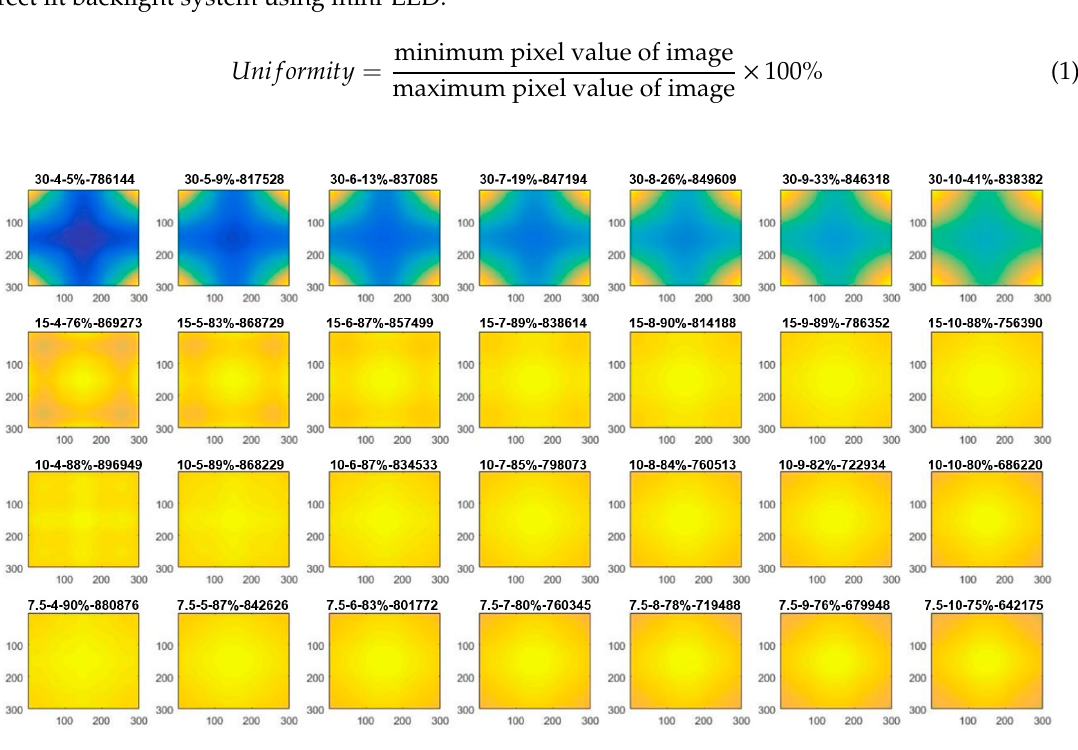
Figure 6. Array analysis of SMD. Figure 5 is an image series of an array of CSPs. Qualitatively, when Pitch = 30 mm, since the illumination type of the light source is the Gaussian distribution, the light pattern cannot be effectively opened in the interval of OD = 4 mm to 10 mm. Therefore, the images all show obvious cross-dark characteristics (blue area). As shown in Figure 6, SMD also has the same characteristics, while FDCSP has no obvious cross-dark band when OD = 8 mm or more, such as Figure7. Based on the above results, the bat wing light type clearly has the ability to provide large Pitch solution on the display plane. On the other hand, as can be seen from Figure 5, Figure 6 and Figure 7, the image uniformity increases significantly as the Pitch shrinks and the OD increases until the OD is large enough or the Pitch is small enough to achieve saturation. As shown in Figure 5, Figure 6 and Figure 7, the uniformity of the image has not changed significantly when OD > 6 mm or Pitch < 7.5 mm. This parameter interval is the saturation interval. In addition, from the value of Intensity, it can be seen that Intensity basically decreases with OD increasing.